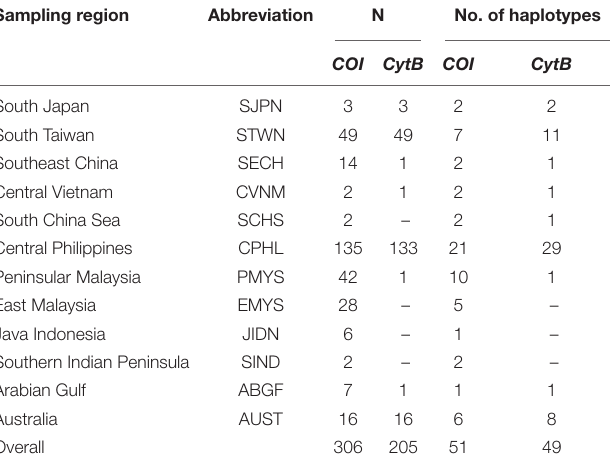
TABLE 1 | Sampling region and abbreviations, sample size (N), and the number of haplotypes. Sampling